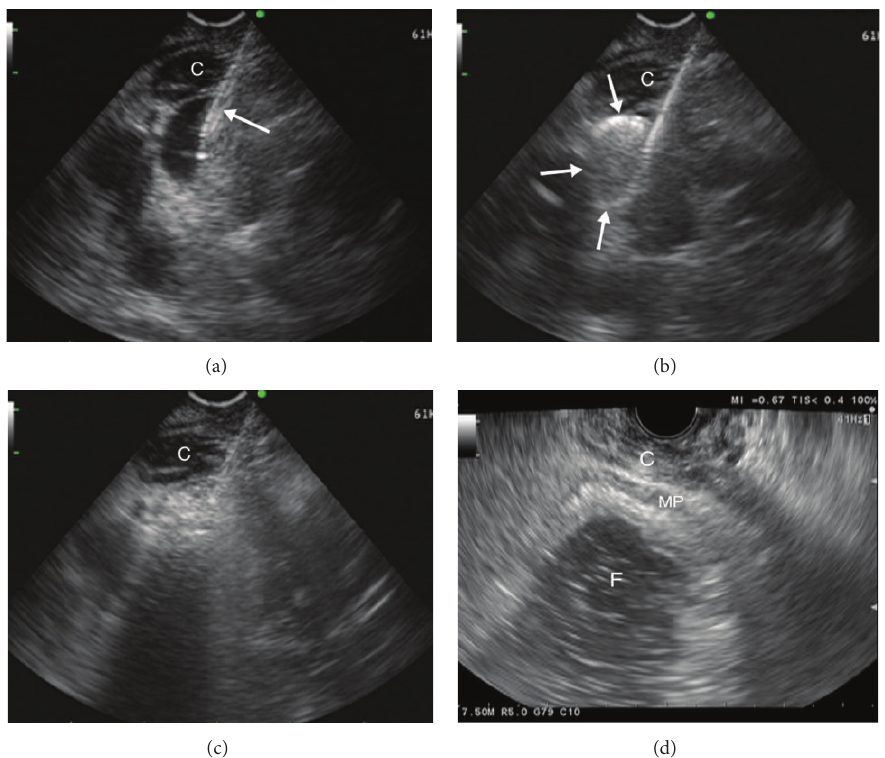
Figure 1: (a) Endosonographic transesophageal view—a 19-gauge needle inserted into the varix (arrow). (b) Coil delivery (arrows) through the 19-gauge needle. (c) Injection of 1mL of cyanoacrylate. (d) Fundal varices obliterated. C: crus muscle, F: fundus; MP: muscularis propria of stomach wall. (Images curtsey of